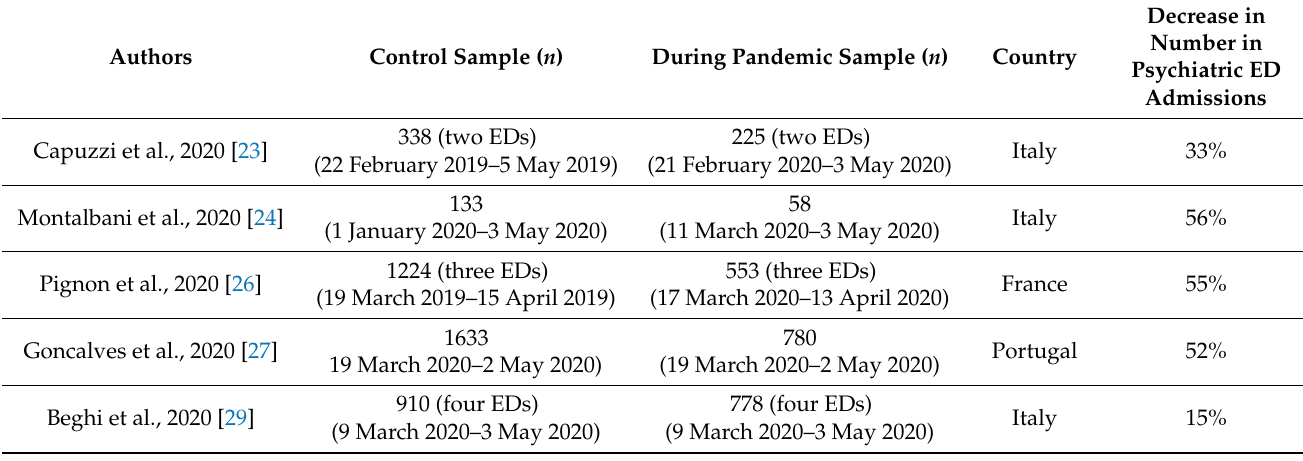
Table 3. Previous studies comparing ED admission between a control and a during pandemic